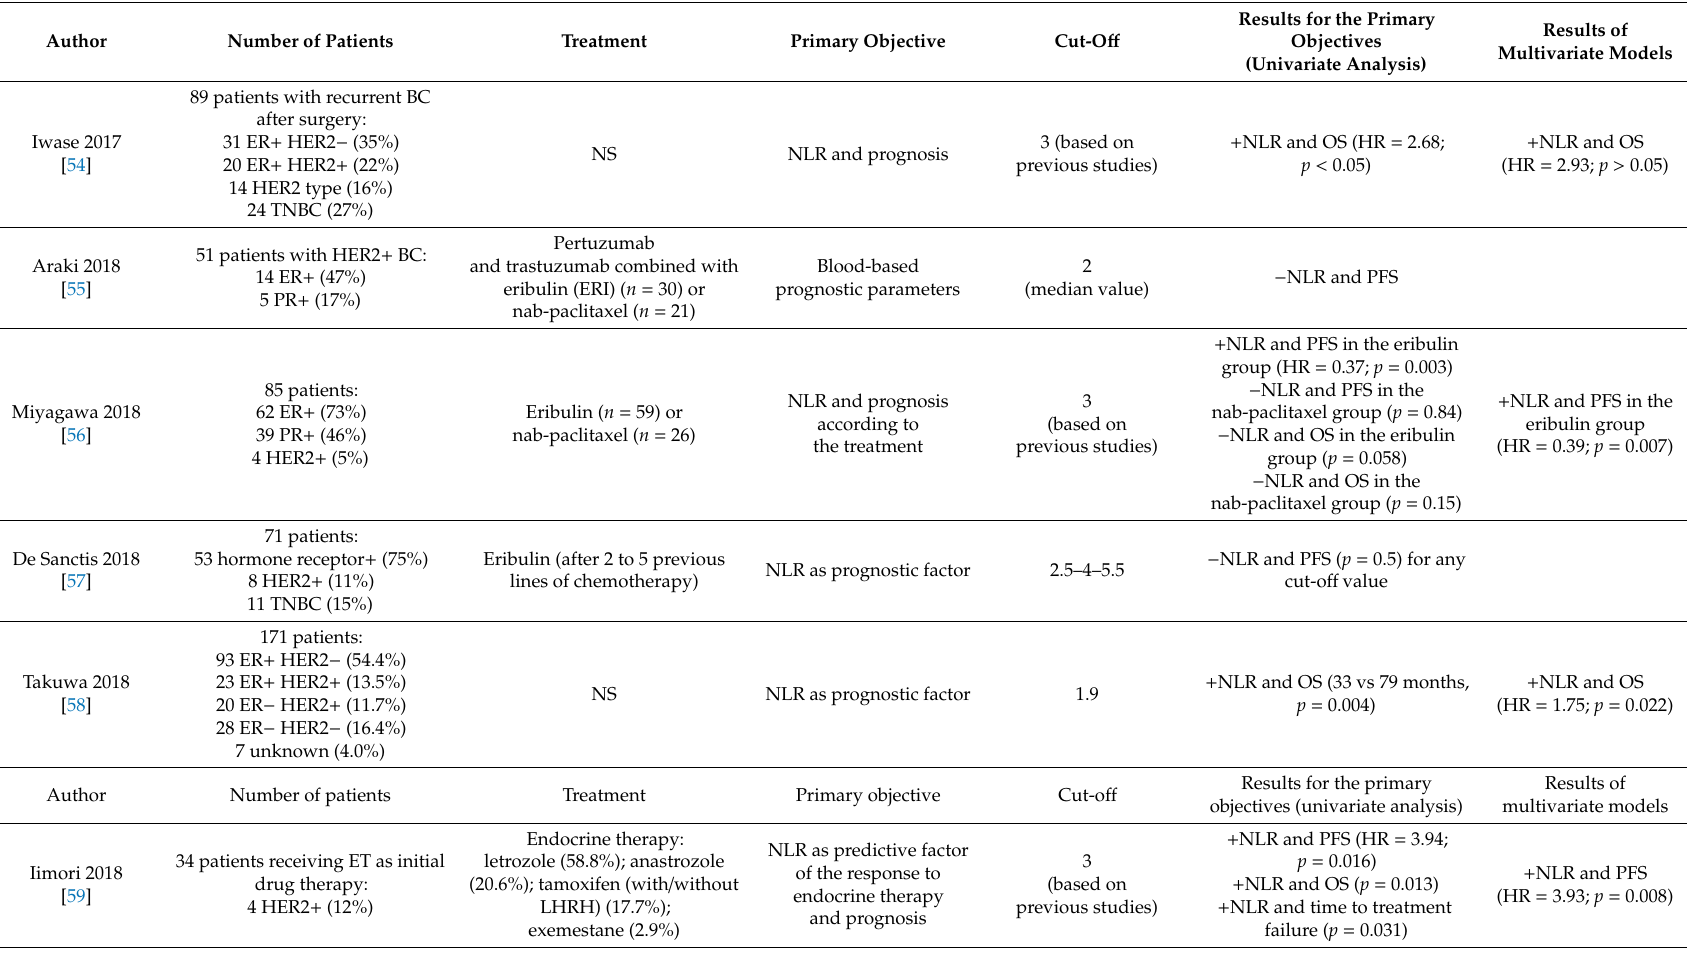
Table 5. Articles with data on NLR as prognostic factor in patients with metastatic breast